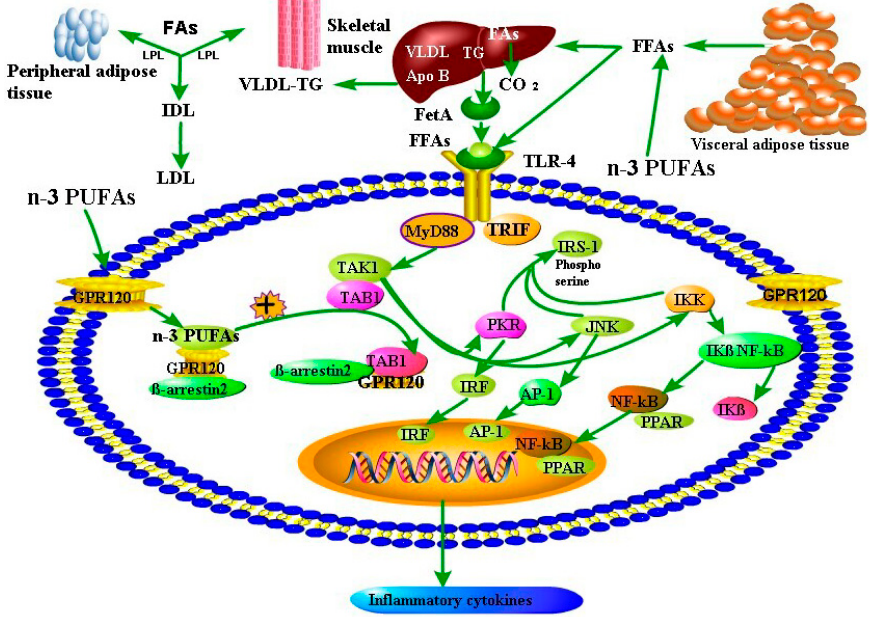
Figure 6. The underlying mechanisms of n -3 PUFAs protecting metabolic syndrome. Dysfunctions of lipid metabolism and inflammation contribute to metabolic syndrome. The high lipolytic rate in visceral adipose provides the liver with large amounts of FFAs. Impaired fat oxidation stimulates fatty acid esterification into TG, together with an augmented synthesis of Apo B, cholesterol and the secretion of VLDL. Moreover. FFAs may result in the activation of TLR4 pathways. Fet-A functions as an adaptor between FFAs and TLR4 signaling in lipid-induced inflammation. FFAs stimulate TLR-4 signaling by binding Fet-A, which then binds TLR-4. JNK, IKK, and PKR play important roles in upregulating the transcription factors (including AP-1, NF- κ B, and IRF), resulting in the production of inflammatory cytokines. Moreover, these kinases can inhibit insulin signaling via serine phosphorylation of IRS-1. n -3 PUFAs modulate lipid and lipoprotein metabolism. Reduced VLDL production in the liver largely results from decreased availability of FFAs released from adipose stores, together with suppression of lipogenic genes and induction of genes involved in fatty acid oxidation. Inhibition of FFAs released from visceral adipose tissue due to a higher circulating n -3 PUFAs concentration, the TLR-4/MyD88 signaling pathway would be suppressed. Accordingly, the expression levels of PKR, IKK, JNK are inhibited. Finally, the release of inflammatory cytokines from adipocytes will be decreased. PPAR are transcription factors and regulate gene expression. PPAR are activated by non-covalent binding of ligands, such as n -3 PUFAs and eicosanoid mediators. Through activation of PPAR, n -3 PUFAs are able to regulate metabolism and other cell and tissue responses, including adipocyte differentiation and inflammation. Activation of GPR120 by n -3 FUFAs through binding β -arrestin 2 and TAB1 could inhibit pro-inflammatory pathways. Abbreviations: PUFA, polyunsaturated fatty acid; FFAs, free fatty acids; Apo B, apolipoprotein B; IDL, intermediate-density lipoprotein; LPL, lipoprotein lipase; TAG, triacylglycerol; FA, fatty acid; Fet-A, Fetuin-A; TLR-4, toll-like receptor 4; AP-1, activator protein-1; IKK, inhibitor of NF- κ B kinase; IRF, interferon regulatory factor; NF- κ B, nuclear factor- κ B; IRS-1, insulin receptor substrate 1; JNK, c-jun N-terminal kinase; PKR, protein kinase R; TRIF, TIR domain-containing adapter-inducing interferon- β ; MyD88, myeloid differentiation factor 88. TAK1, transforming growth factor-activated kinase 1; TAB1, transforming growth factor- β activated kinase 1 binding protein 1; PPAR, peroxisome proliferator-activated receptor; GPR120, G-protein-coupled receptor